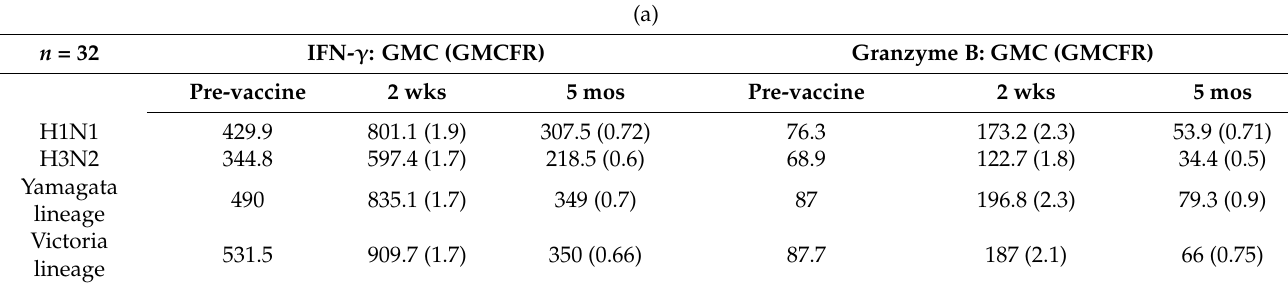
Figure 1. Cell-mediated immunity (IFN- γ and granzyme B levels) to the four vaccine antigens: ( a ) A(H1N1); ( b ) A(H3N2); ( c ) B(Yamagata lineage); ( d ) B(Victoria lineage). IFN- γ and granzyme B levels were measured at pre-vaccination (0), two weeks post-vaccination (2 wks), and five months post-vaccination (5 mos). Table 1. Geometric mean concentrations and fold rises in the levels of antigen-specific IFN- γ and granzyme B in vaccinated subjects before and after vaccination, and percentage of subjects with ≥ 1.5-fold increase in IFN- γ and granzyme B levels after vaccination: (a) GMCs and GMCFRs upon the stimulation of whole blood with vaccine antigens; (b) percentage of subjects with ≥ 1.5-fold increase in IFN- γ and granzyme B levels upon vaccination.